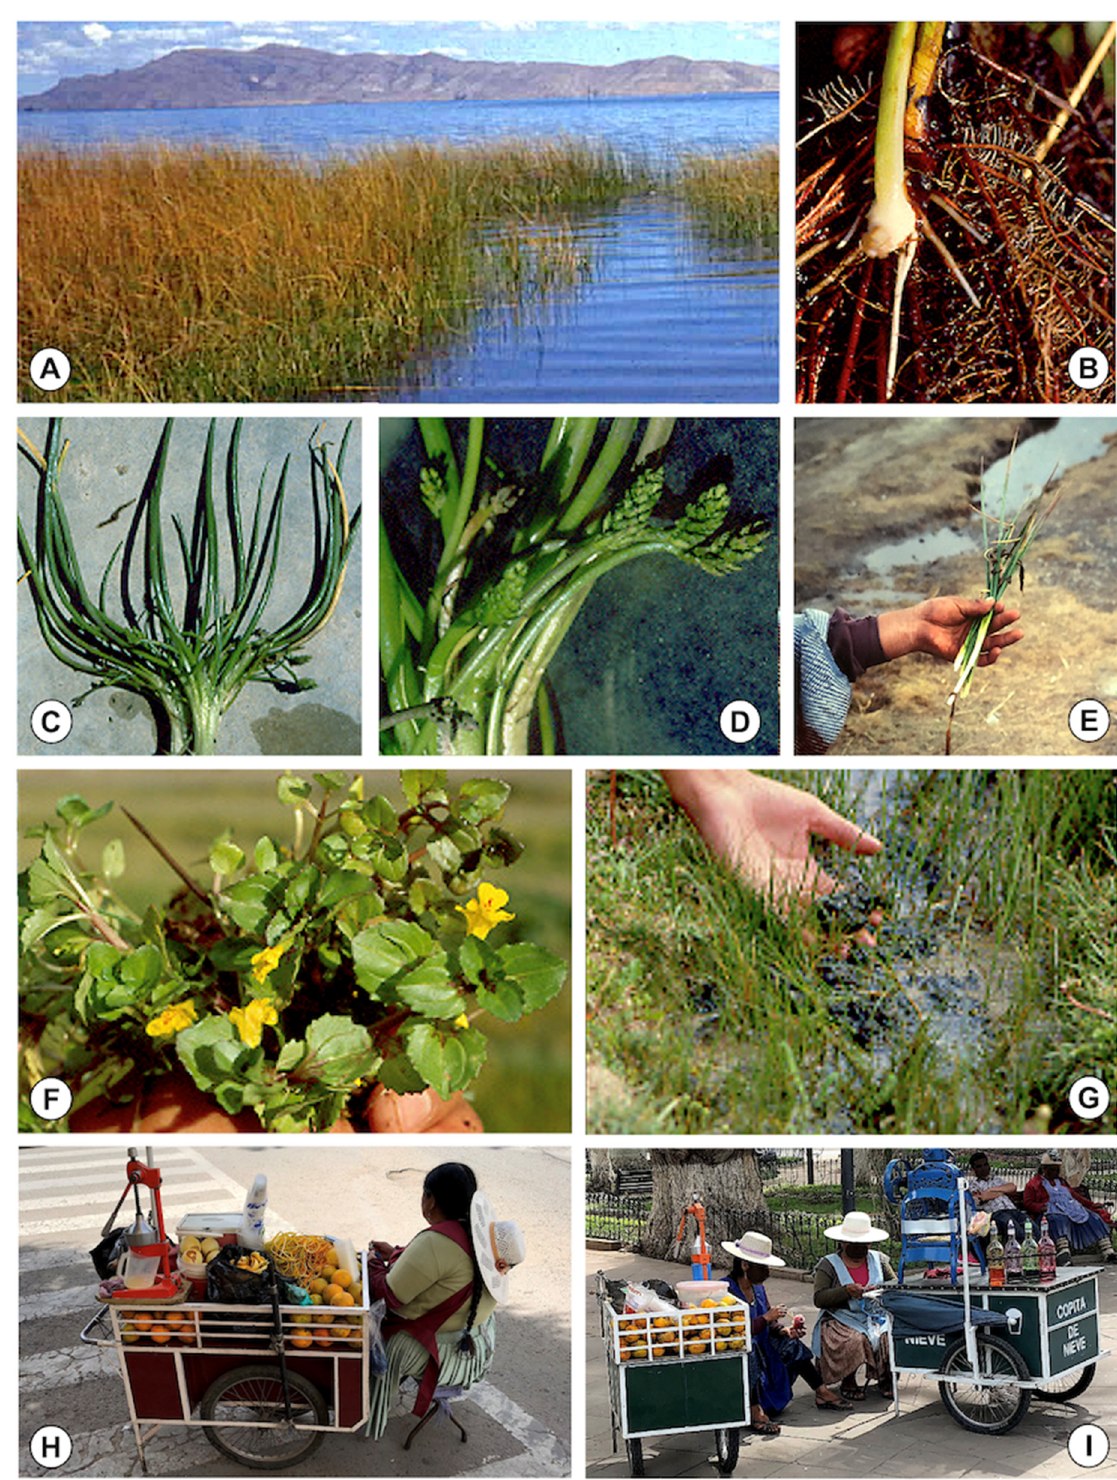
Figure 5. Consumption of potentially transmitting local plants: ( A , B ) Stems of totora ( Schoenoplectus totora ) at the shore of Lake Titicaca ( A ) and detail of its bulb ( B ); ( C – E ) The local word “totorillla” concerns different freshwater plant species such as Lilaea sp. ( C , D ), Eleocharis spp. ( E ) and others such as Juncus spp. ( F ) The word “okororo” is used by Aymaras to refer to several similar freshwater plants as Mimulus glabratus ; ( G ) Llaytha is a biomass of colonies of a Nostoc cyanobacterium which grows in wet places and known as “cochayuyo” by the Aymara inhabitants; ( H , I ) Ambulant hawking by “cholitas” in city streets implies selling of plants and fruits from the endemic rural neigbouring areas, as well as beverages made with such vegetables, which potentially underly urban infection risk. ( A , E , H , I ) Photographs S. Mas-Coma; ( B – D , F , G ) Photographs R.